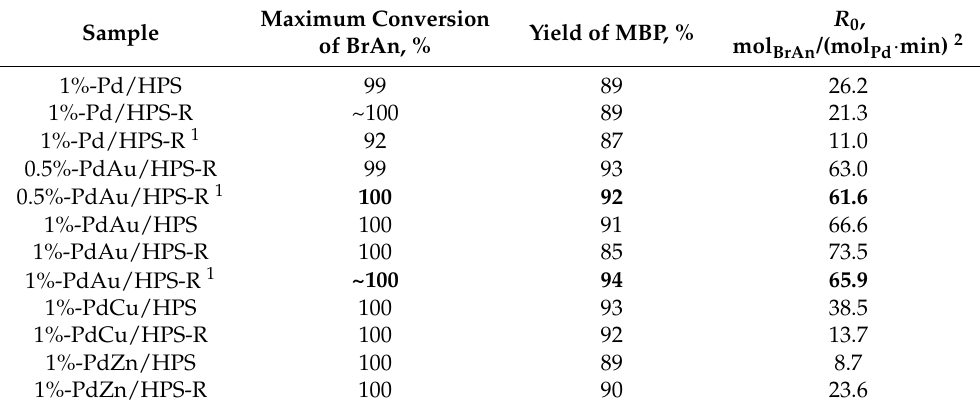
Table 2. Catalytic results for the synthesized mono- and bimetallic samples (1 mmol of BrAn,